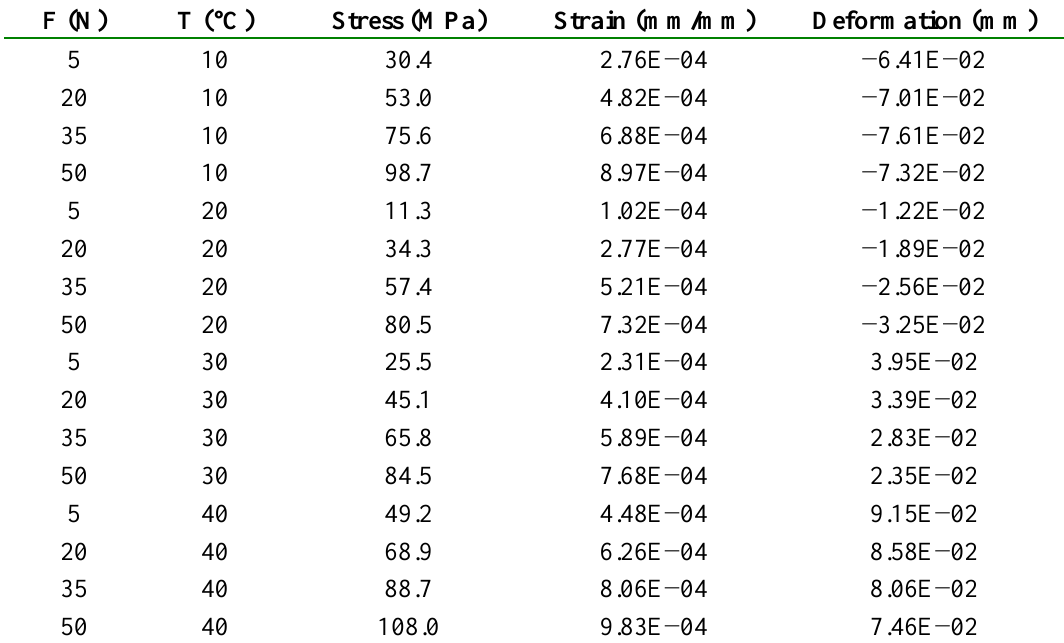
Table 2. Simulated data for the von Mises stress, von Mises strain and the total